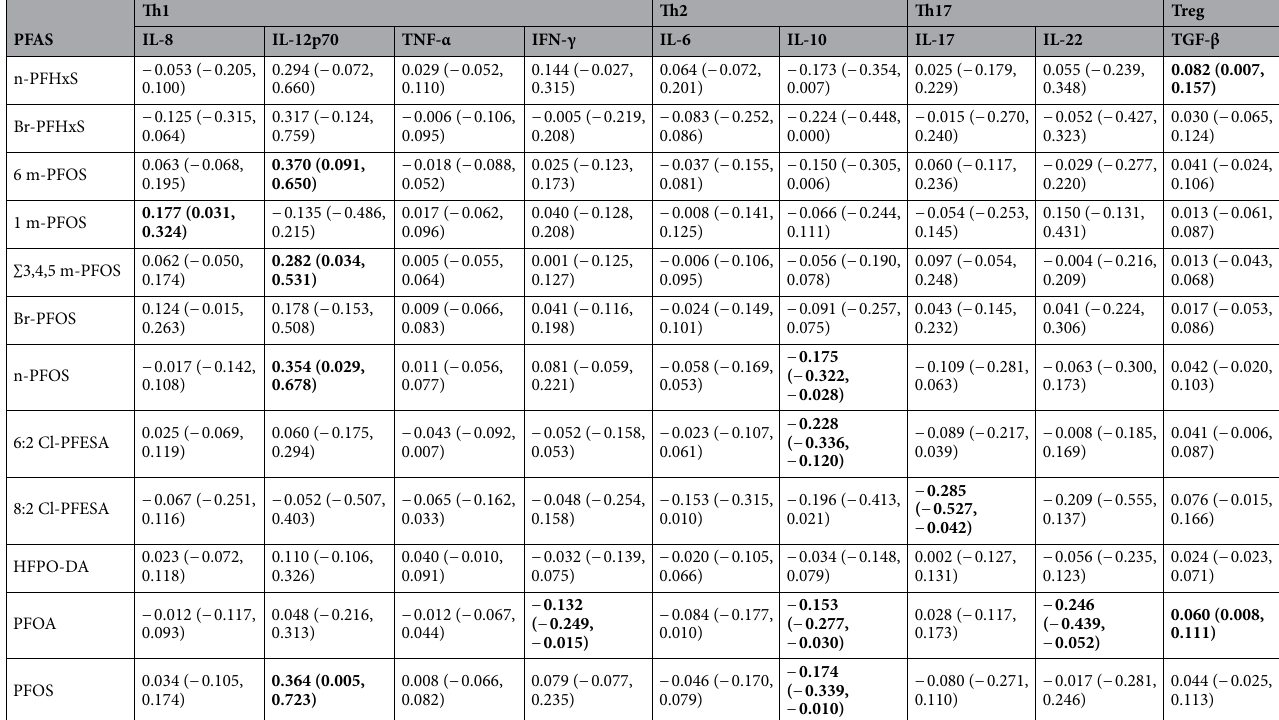
Table 4. Associations between single ln-transformed PFAS and cytokines in multivariable linear regression (n = 198)*. *Adjusted for age, BMI, age at menarche, and education. Bold characters indicate significance, P < 0.05.